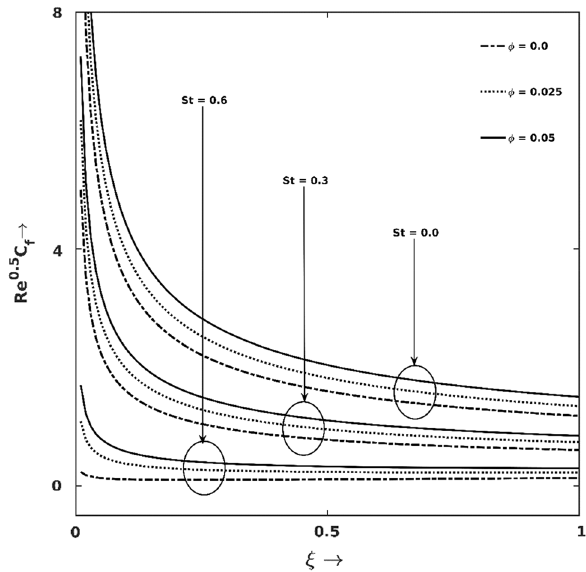
Figure 4. Friction coefficient ( √ ReC f